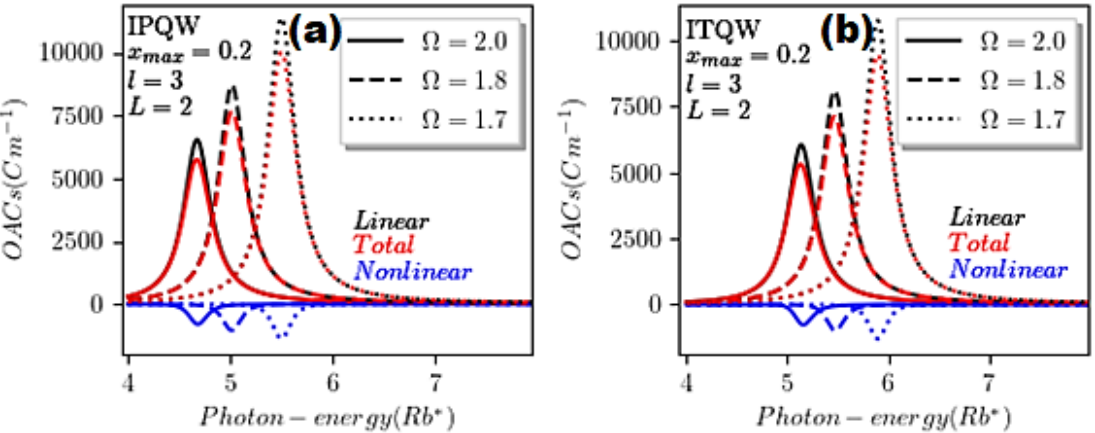
Figure 6: The OACs change versus incident photon energy (R*) with fixed barriers/well widths (L=2; l=3) and x =0.2 for three different values of Ω=2(1.8; 1.7) considering two potential max shapes IPQW (a) and ITQW (b).